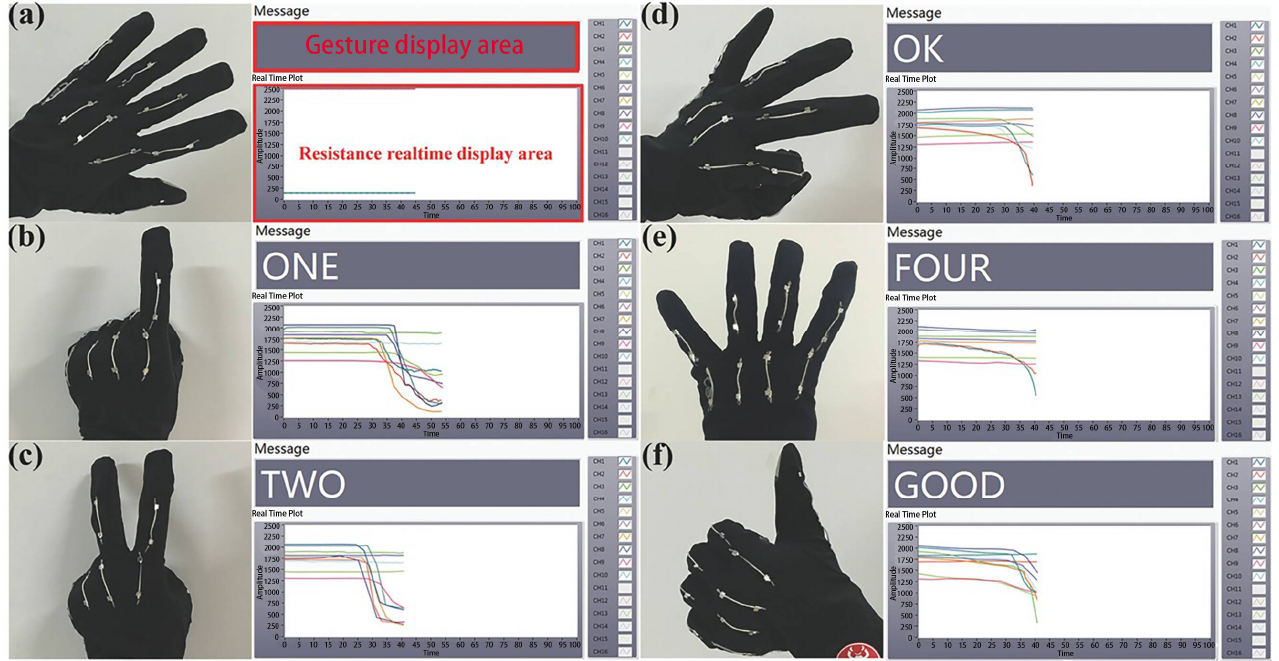
Figure 14. A data glove with ten fiber strain sensors fixed